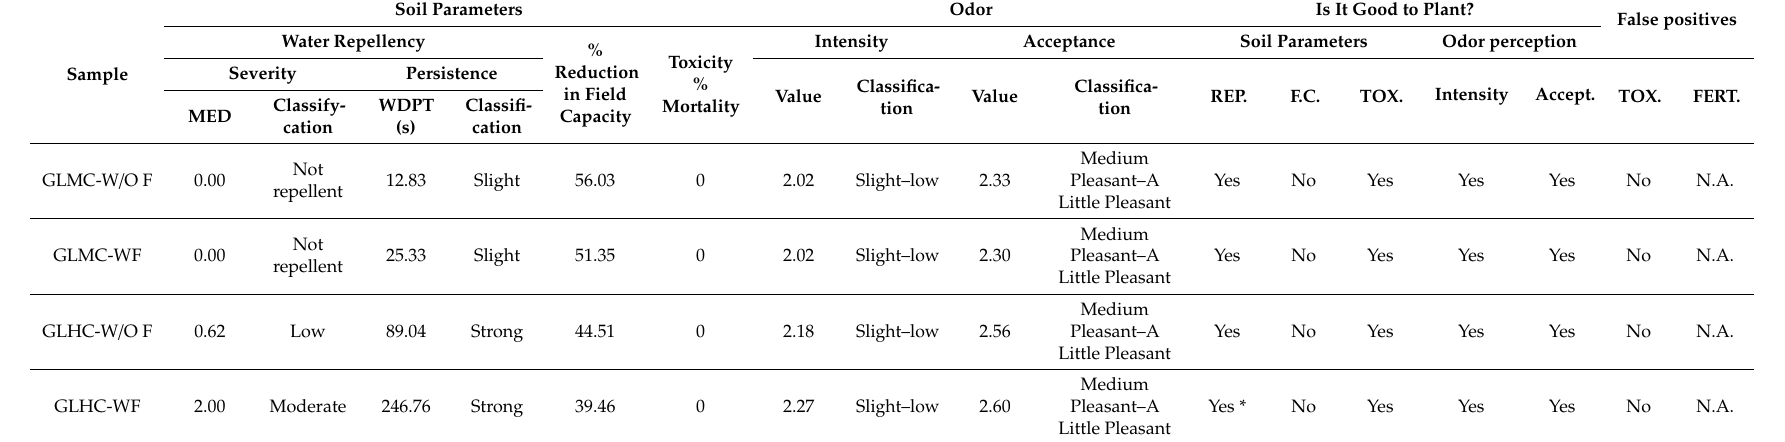
Table 5. Evaluation: When they say “it is good to plant”, is it really satisfactory?—Gleysol.